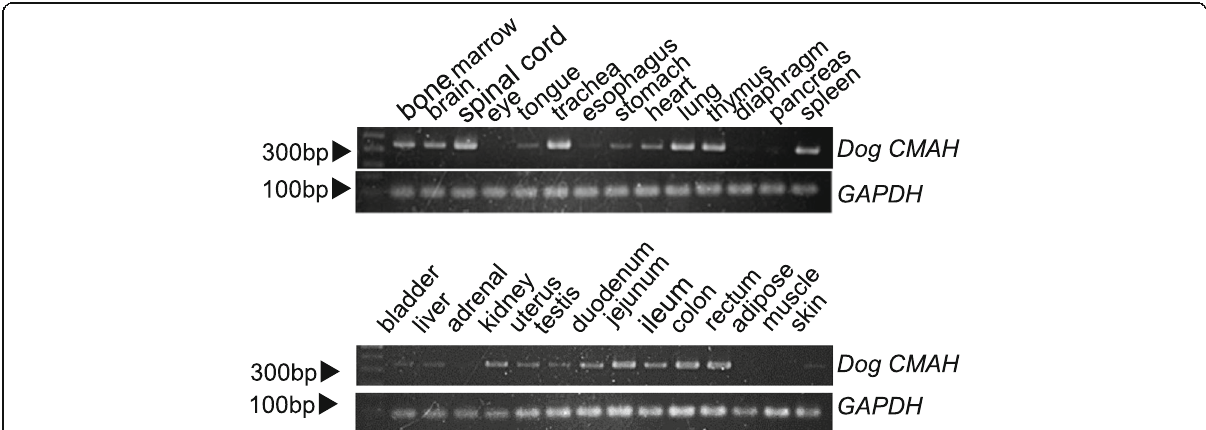
Fig. 3 RT-PCR analysis of canine CMAH mRNA in various tissues of dog. Dog CMAH cDNA encompassing exons 2 to 4 (342 bp) was amplified from various tissues. The integrity of RNA was examined using the primer pair for glyceraldehyde-3-phosphate dehydrogenase (GAPDH)